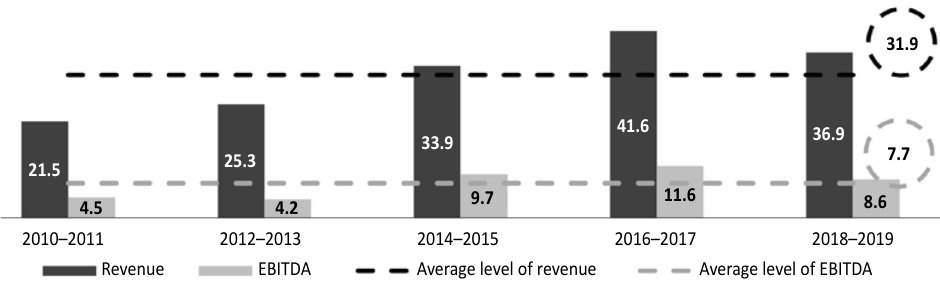
Figure 6. Average level of revenues and EBITDA of a company acquired by a search fund outside the USA and Canada in 2010-2019 (PLN million)